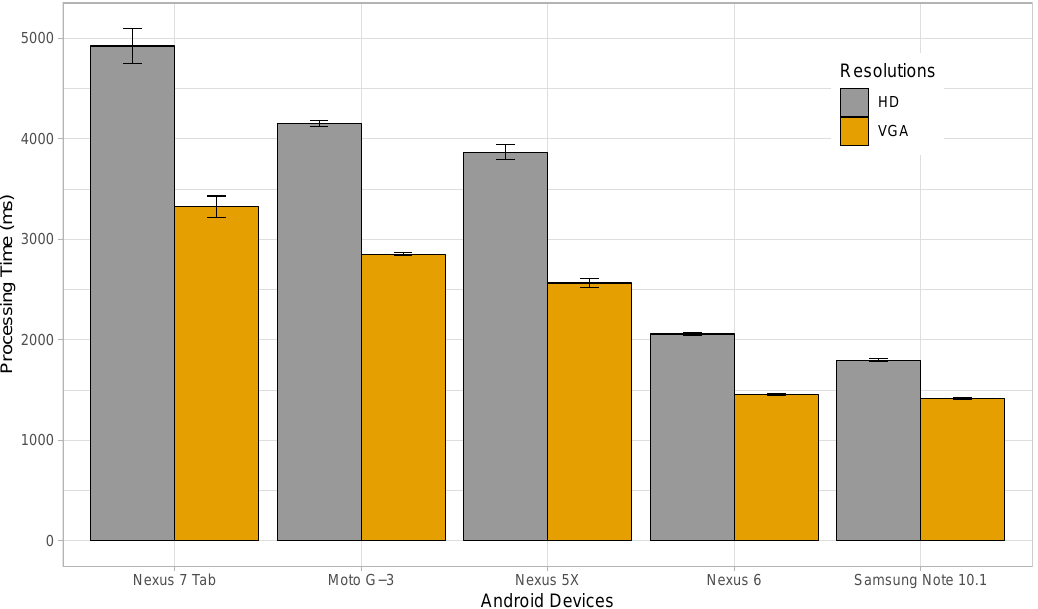
Figure 9. Time taken to processes images by different Android